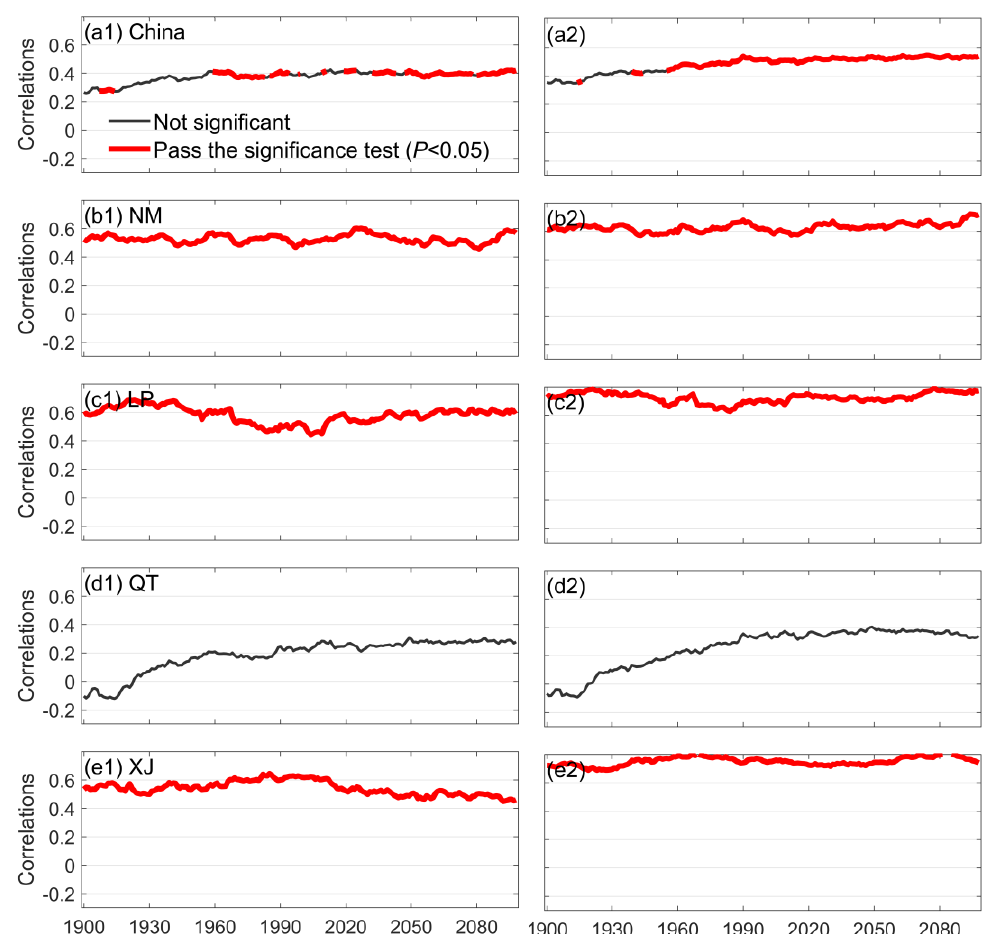
Figure 3. Correlation between GPP IAV and SM IAV for Chinese grasslands during the period 1901–2099. ( a1 , b1 , c1 , d1 , e1 ) is annual, and ( a2 , b2 , c2 , d2 , e2 ) is the warm season. The correlation between SM IAV and GPP IAV per year in the warm season was calculated with a 41-year sliding window, i.e., by calculating the correlation between the two variables from 1861 – 1901 as the result in 1901, and so on, to find the correlation from 1901 – 2099. The red line in the figure shows the years in which the correlations passed the significance test ( p < 0.05).